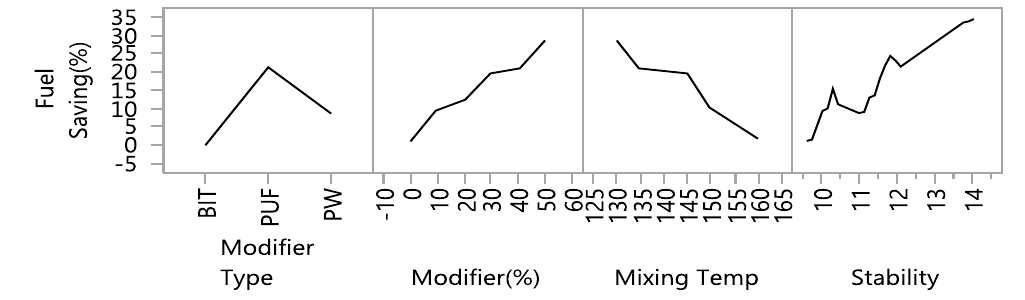
Figure 5. Prediction profile of fuel saving.